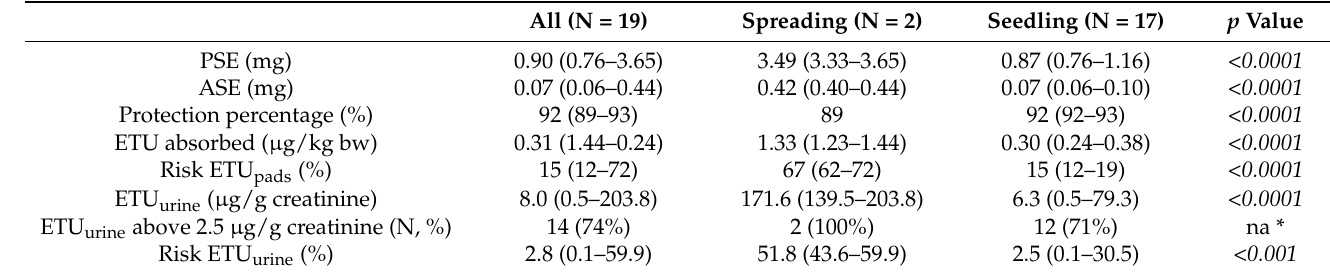
Table 3. ETU exposure assessment results from pads and urine